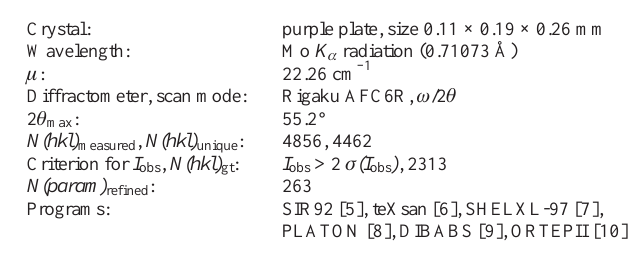
Table 1. Data collection and handling.